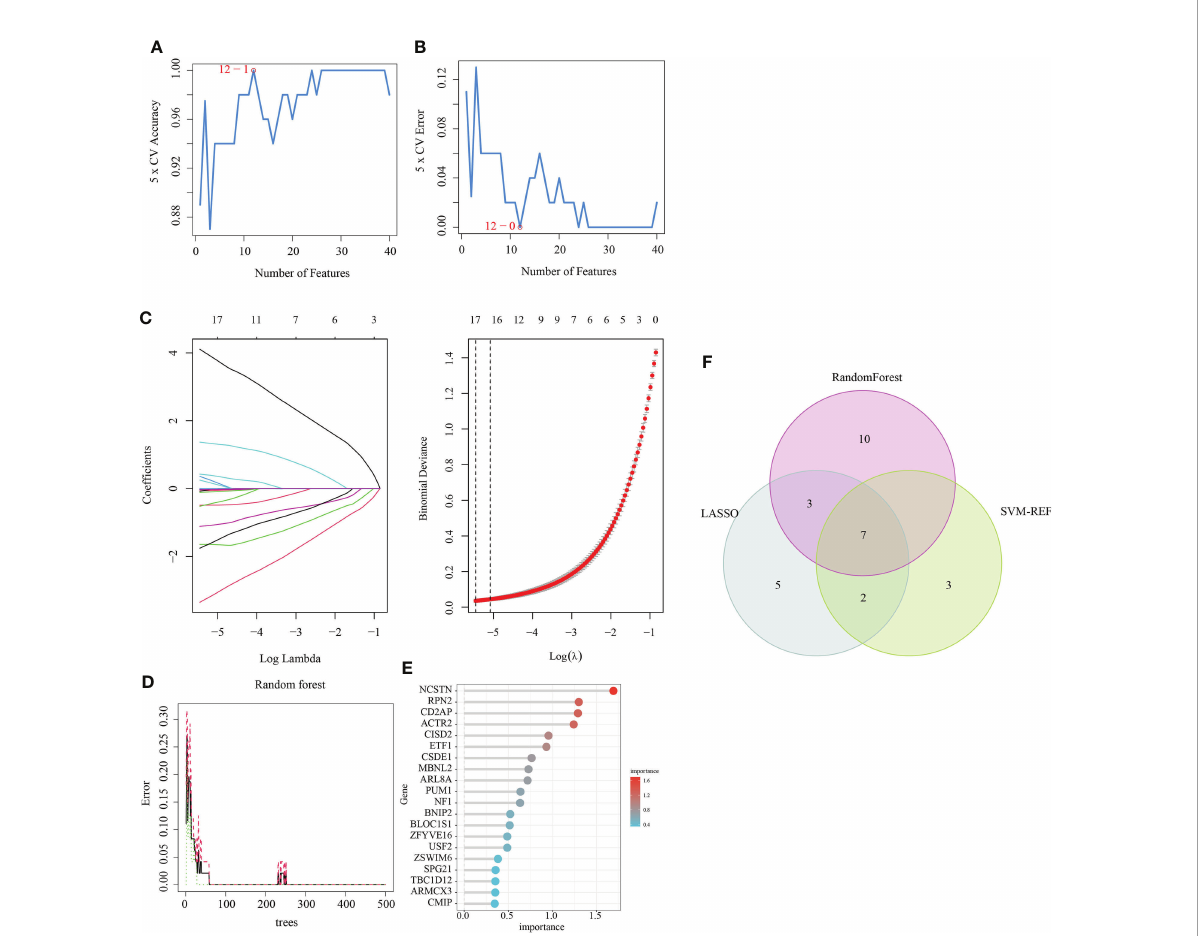
FIGURE 3 Feature gene selection. (A, B) Biomarker signature gene expression validation via support vector machine recursive feature elimination (SVM – RFE) algorithm selection. (C) Adjustment of feature selection in the minimum absolute shrinkage and selection operator model (LASSO). (D) random Forest error rate versus the number of classi fi cation trees. (E) The top 20 relatively important genes. (F) Three algorithmic Venn diagram screening